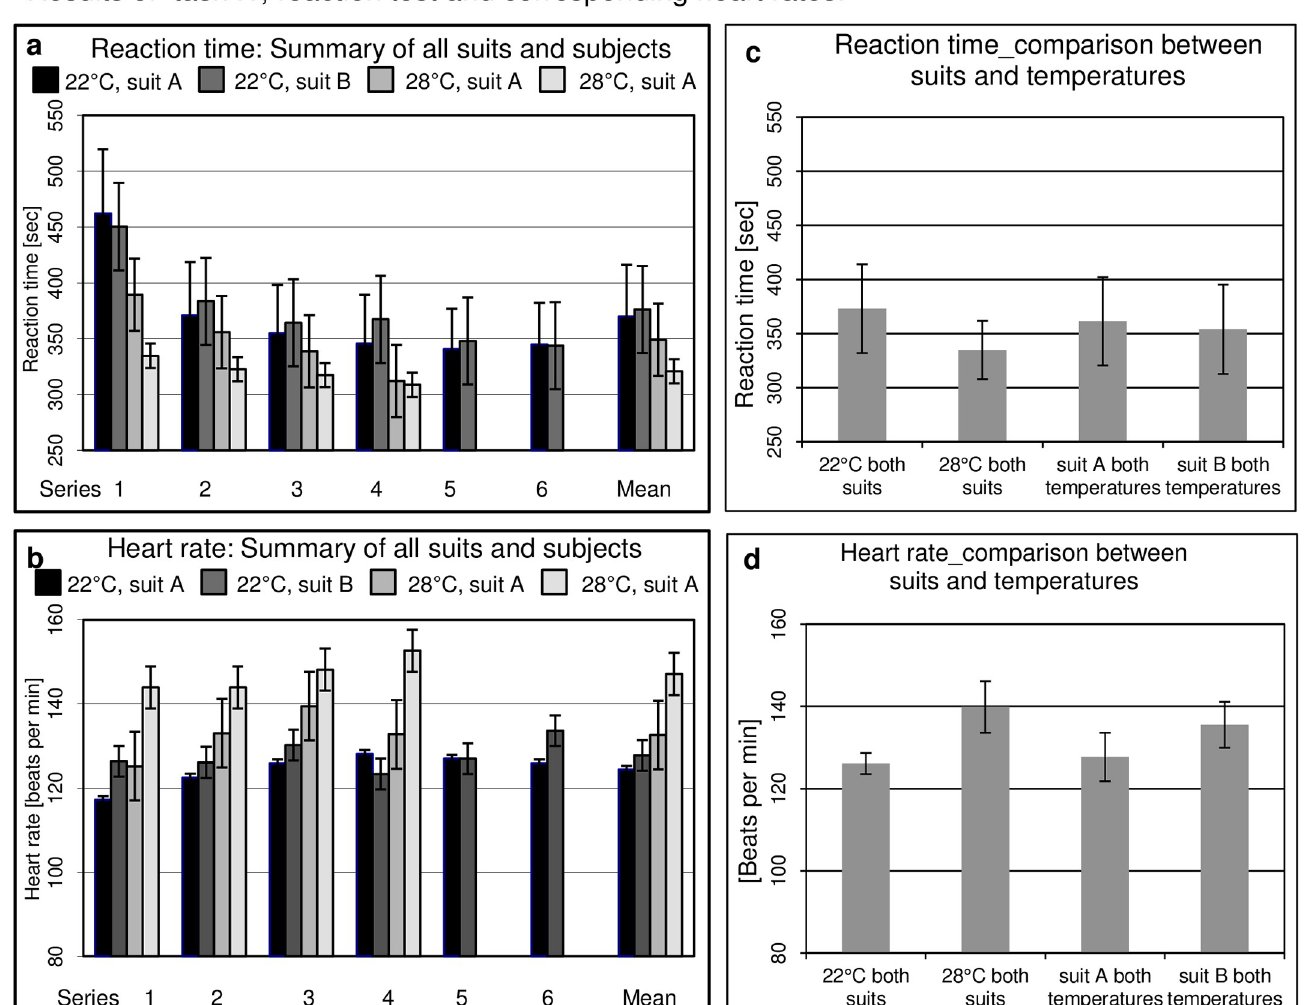
Fig 5. Task IV. Reaction time. Reaction time was evaluated by digital readouts on a screen indicating to tap four touch sensors with the hands located on the left and right side in front of and behind the subject and two touch sensors for the